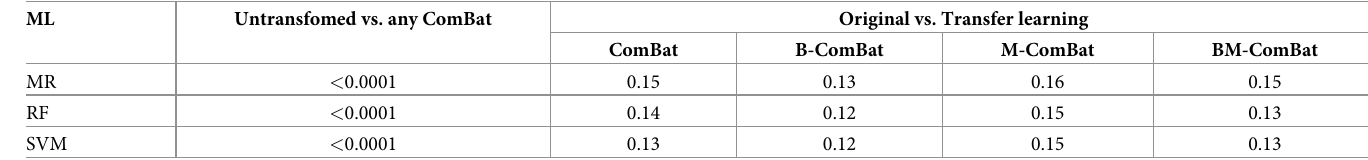
Table 4. P-values of Welch’s t-test comparing ML algorithms performances on different 4 ComBat versions using original and TL data. ML Untransfomed vs. any